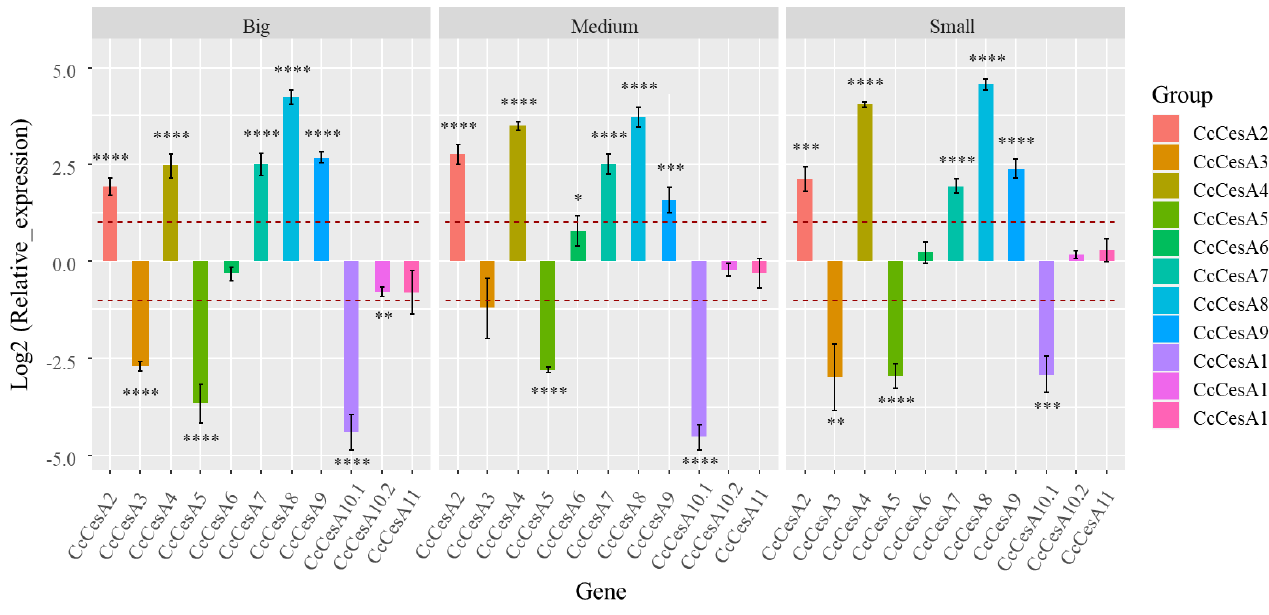
Figure 8. The relative expression levels of CcCesAs in different DBH of C. citriodora . Each gene was controlled by a small DBH (relative expression level close to 1). Error bars indicate standard error of four biological replicates. * p ≤ 0.05, ** p ≤ 0.01, *** p ≤ 0.001, **** p ≤ 0.0001.